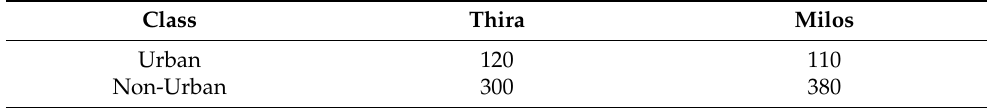
Table 2. Number of bootstrap samples on every image of